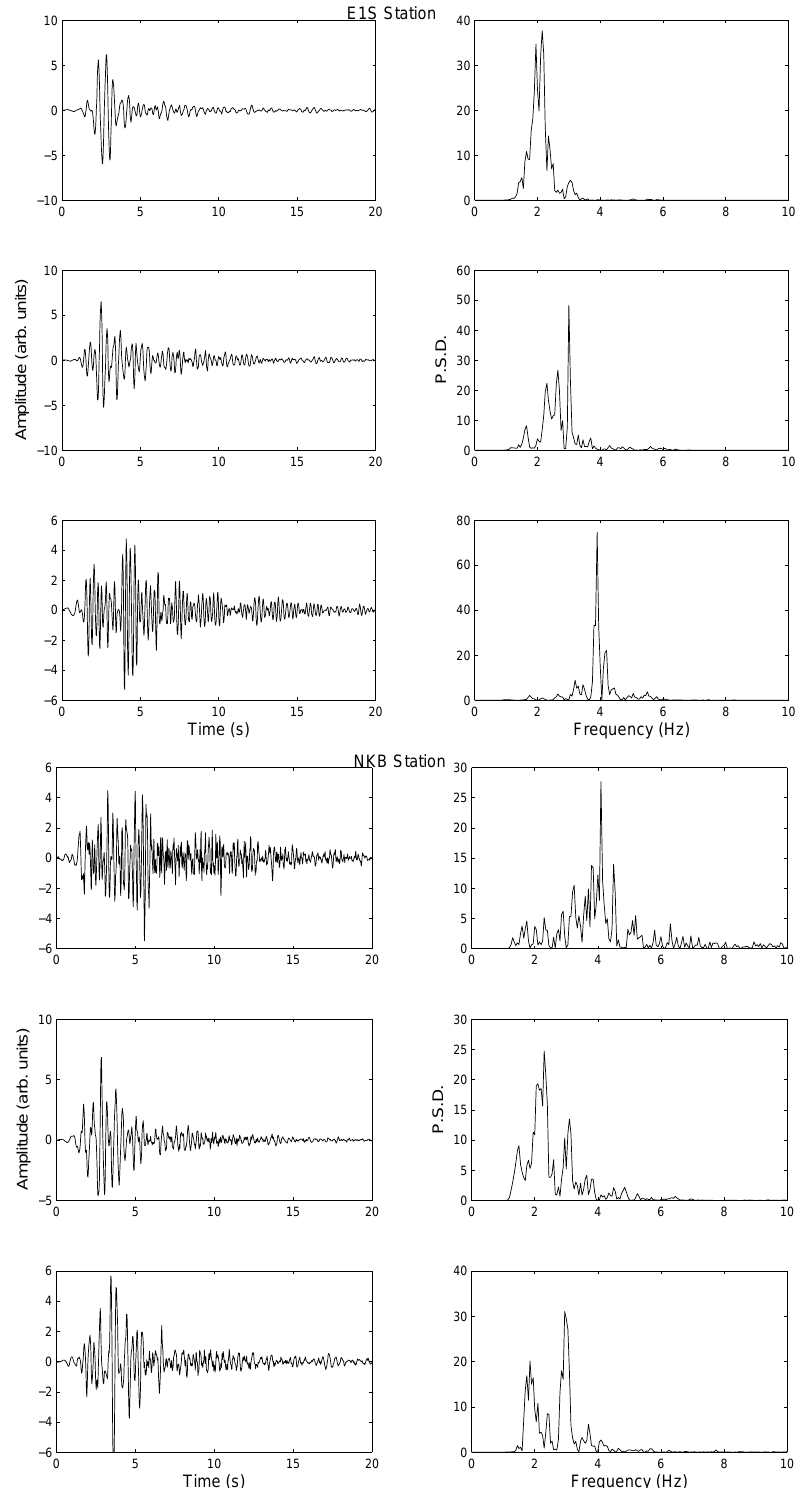
Fig. 8. Independent signals extracted by ICA in time domain and relative frequency content considering the recordings of the two stations closest to the lava lake (from De Lauro et al.,